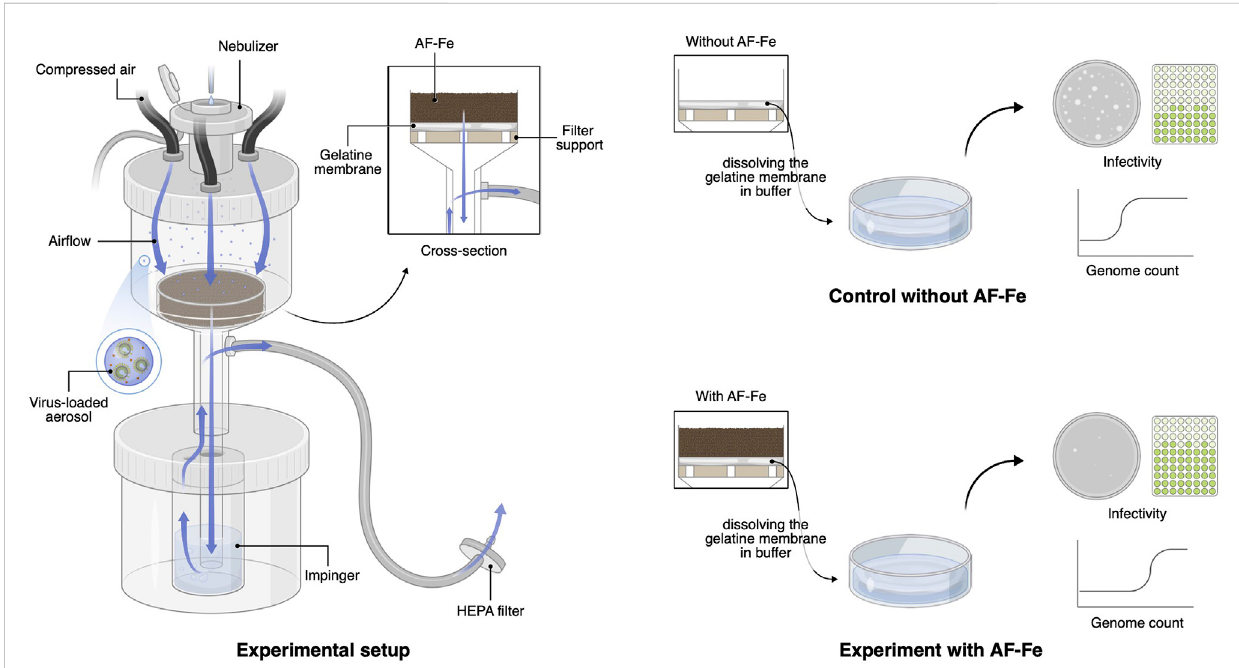
FIGURE 2 Schematicoftheexperimentalsetupandprocedure.Theexperimentalsetup,left,iscomposedof:a fi lterholderwithanebulizer fi ttedonitstopand threehosesconnectedtothreecompressedairtanks;thegranularAF-Feplacedonagelatinemembrane,whichtrapsthevirus-loadedaerosolsthatpass throughtheAF-Femedia;animpingerservingasanadditionaltrappingmechanismforanyaerosolsthatgothroughthegelatinemembrane;aHEPA fi lter asathirdsafetymeasuretoavoidreleasing anyvirus-loaded aerosols intothesurroundingair.Forbothexperimentswith(bottomright)andwithout AF-Fe (top right), the gelatine membrane was dissolved in a buffer to determine the concentration of infectious viruses and the genome